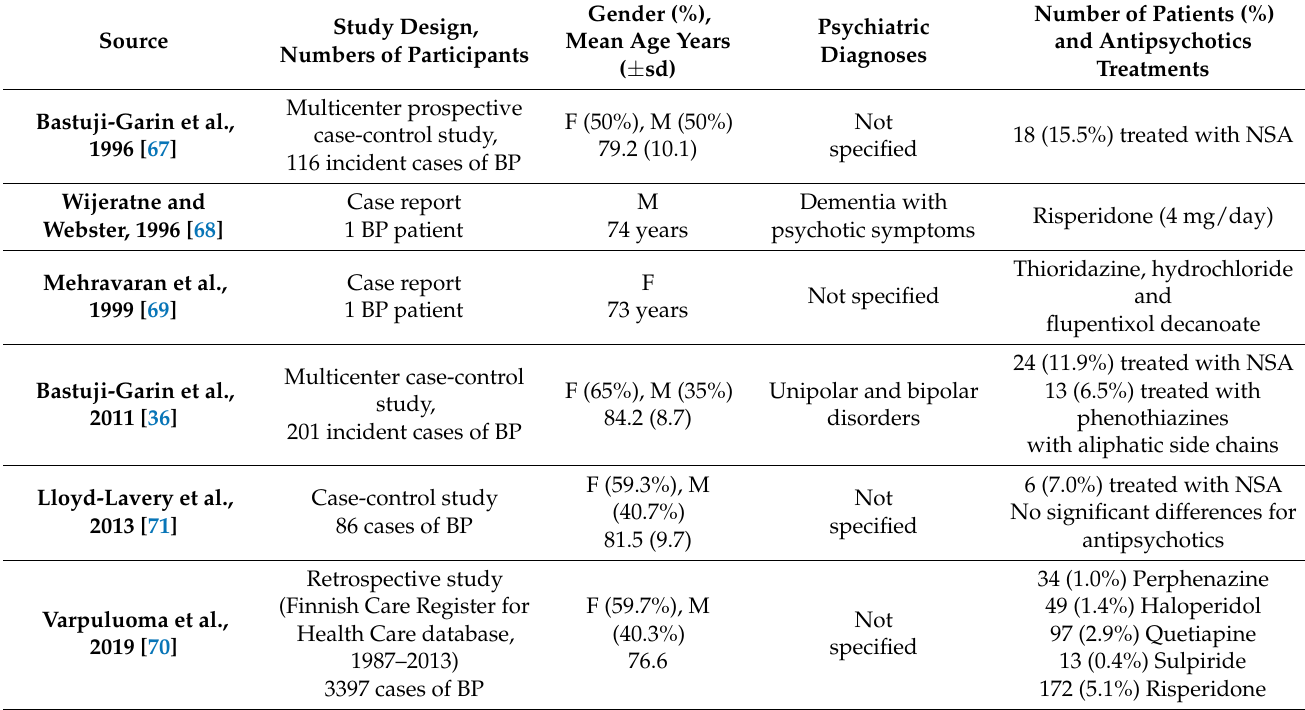
(Table 2). Bastuji-Garin et al. [36], in another multicenter case-control study, identified retrospectively, 201 incident cases of BP, among which only 24 were treated with non- specified antipsychotics and 13 with phenothiazines. The antipsychotic-treated patients had a diagnosis of unipolar or bipolar disorders. Wijeratne and Webster [68], on the other hand, illustrated a clinical BP case after expo- sure to risperidone in an old male patient with dementia and psychotic symptoms. Instead, an additional clinical report described the case of a BP female patient after treatment with thioridazine hydrochloride and flupentixol decanoate [69]. Finally, Varpuluoma et al. [70] reported data from a retrospective study analyzing 3397 cases of BP, with a small percent- age of patients treated with a different type of antipsychotic (range 0.4–5.1%), being the risperidone in the highest percentage (Table 2). In contrast, Lloyd-Lavery et al. [71], in a case-control study including 86 cases of BP, reported no significant differences in patients using antipsychotics compared with controls. Table 2. Clinical studies and cases diagnosing bullous pemphigoid (BP) in association with antipsychotic treatments. Number of Patients (%) Study Design, and Antipsychotics Source Numbers of Participants Diagnoses